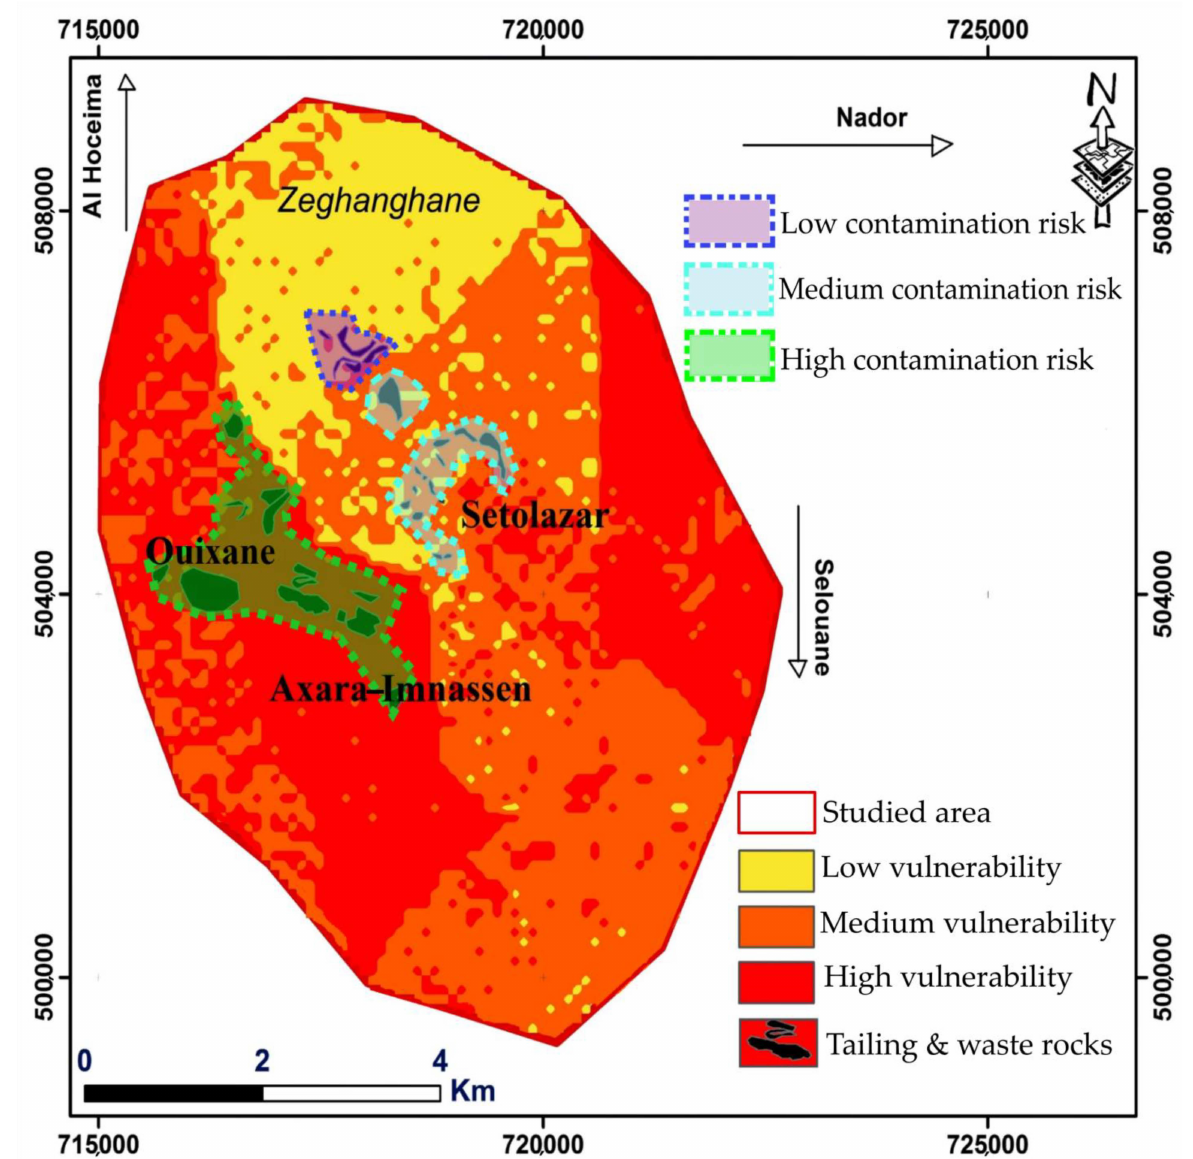
Figure 16. Spatial distribution of tailings on the groundwater intrinsic vulnerability